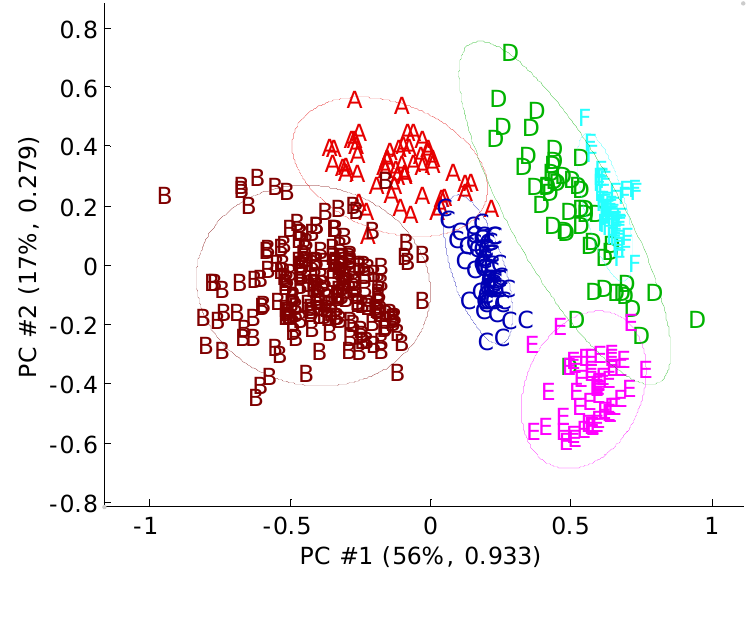
Figure 12. A principal component score plot for the olive oil data set. Each axis is labeled with the percent total variance and the absolute eigenvalue. Each observation of the data set was scaled to [0, 1]. The 95% confidence intervals appear as an ellipse around each class. The sources regions are: (A) Calabria; (B) South Apulia; (C) Inland Sardinia; (D) East Liguria; (E) West Liguria; (F) Umbria.